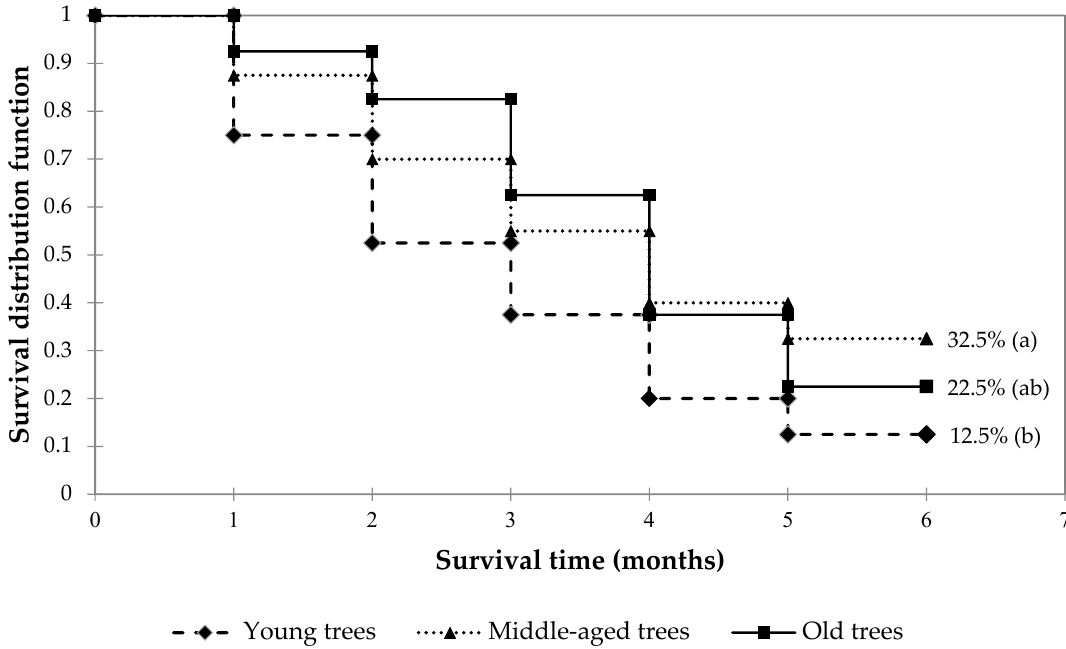
Figure 4. Survival function estimated with the Kaplan–Meier model for Pinus engelmannii Carr. grafts, made with buds coming from different age classes of the scion donor trees (DTA). Values followed by different letters indicate statistical differences according to the Tukey test ( p < 0.05).